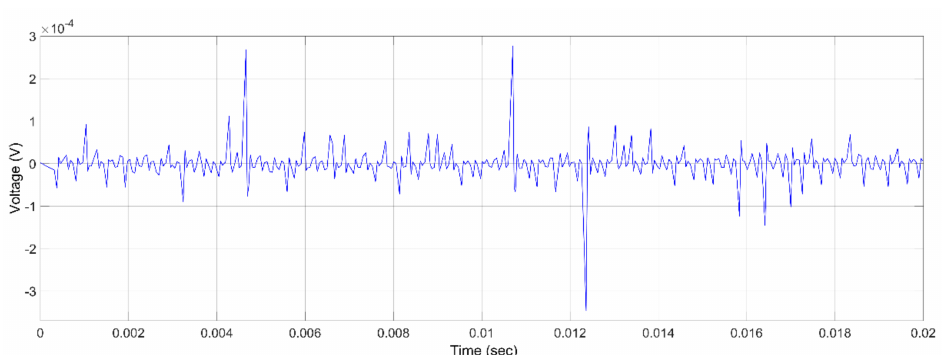
Figure 10. PD at 10 kV.